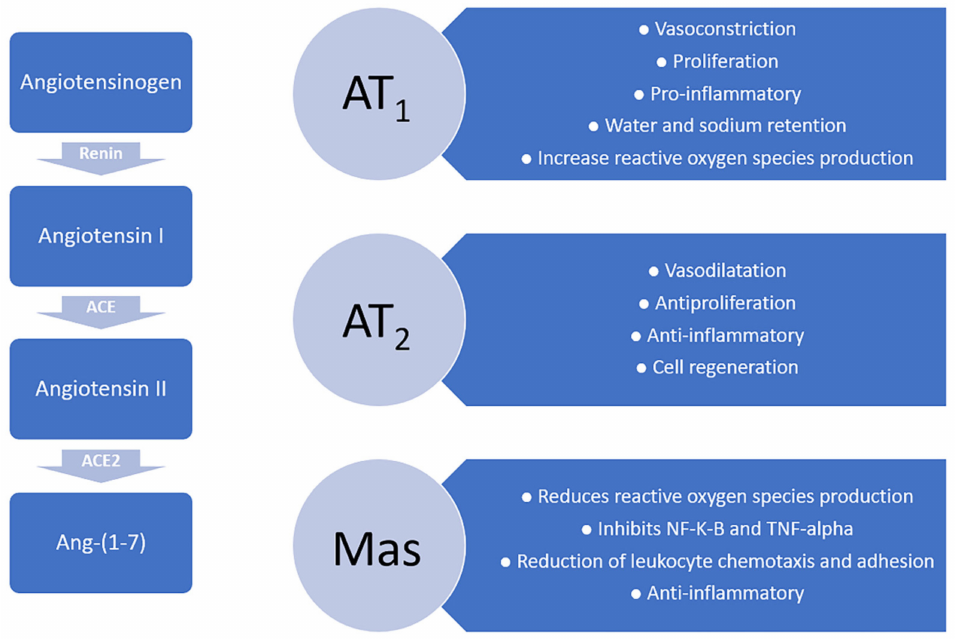
Figure 2. Angiotensin receptors and their